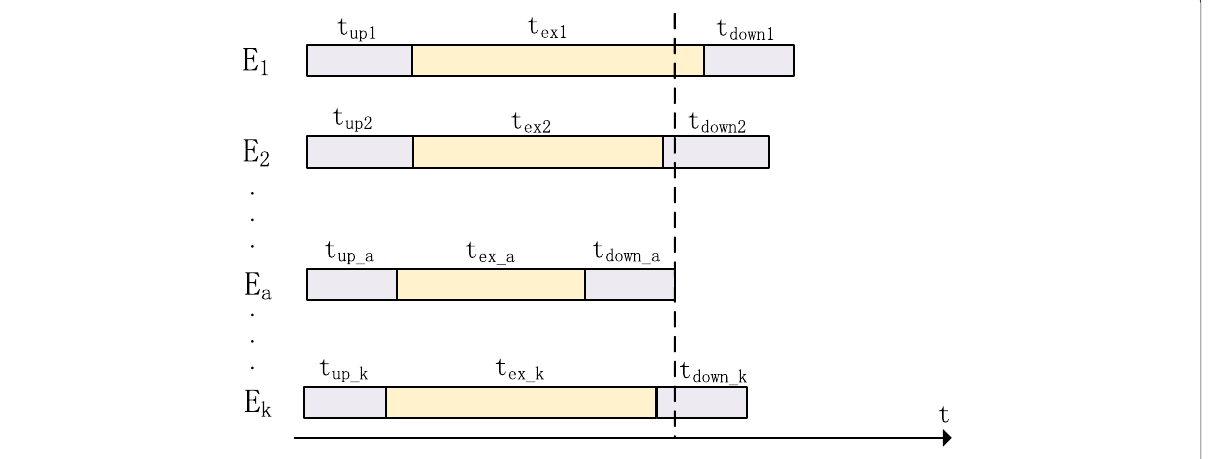
Fig. 6 Multi-resource execution computing